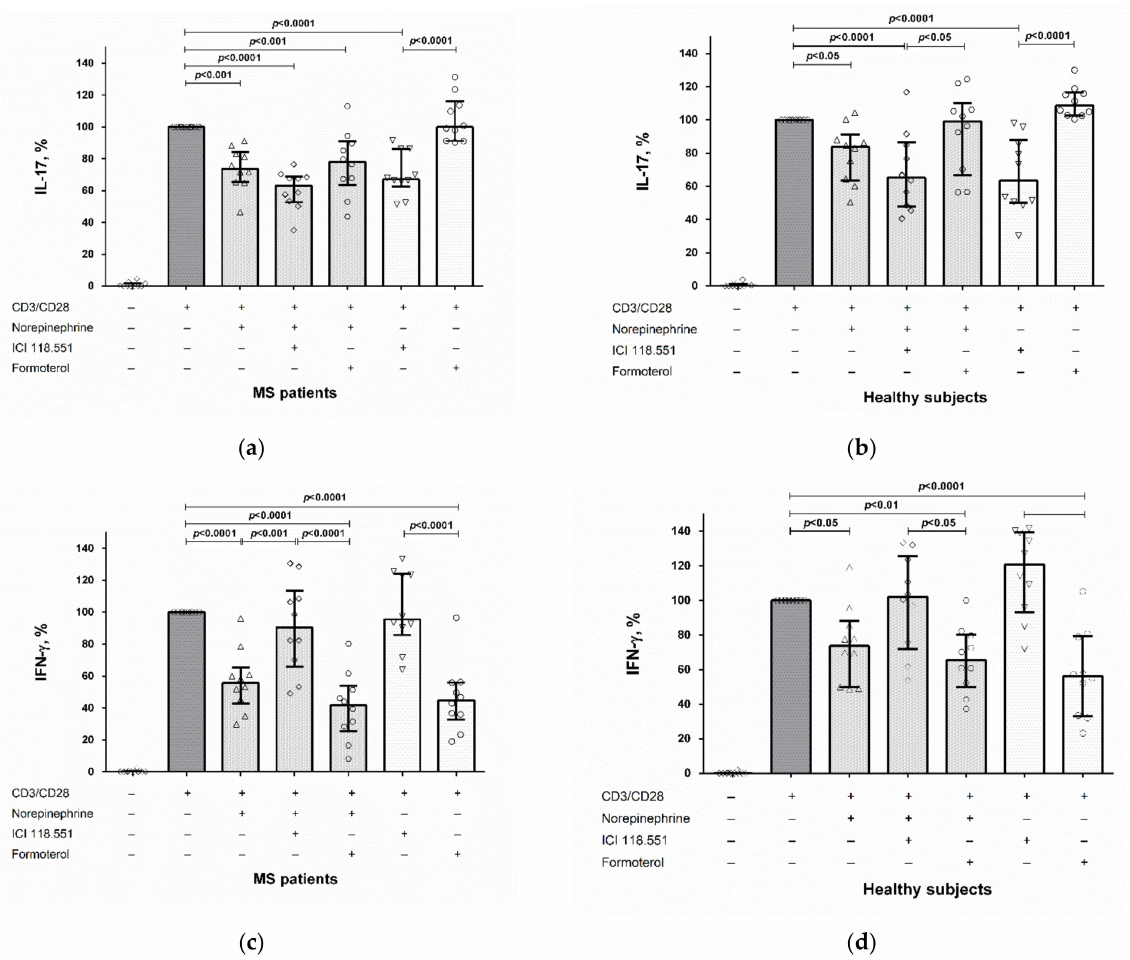
Figure 3. The role of the β 2 -adrenergic receptor in the norepinephrine-mediated suppression of IL-17 ( a , b ) and IFN- γ ( c , d ) production by stimulated PBMCs in MS patients and healthy subjects. CD4 + T cells (8 × 10 4 per 200 µ L per well), obtained from MS patients or from healthy subjects, were pre-incubated with an antagonist or an agonist of the β 2 -adrenergic receptor (ICI 118.551 and formoterol, respectively) (at 10 − 6 M), whereafter norepinephrine (at 10 − 5 M) and anti-CD3/anti- CD28 microbeads or anti-CD3/anti-CD28 microbeads (without norepinephrine) were added to the cultures. After 72 h, the supernatants were collected and submitted to cytokine quantification by ELISA. Data are expressed as the percentage of cytokine production by stimulated cells in the absence of norepinephrine and β 2 -adrenergic receptor antagonist or agonist. The boxes in the graphs correspond to the medians and the whiskers indicate to 25th and 75th percentiles. The symbols in the graphs correspond to the data from each separately MS patient or healthy subject. The median values of the MS and control groups were compared, and the p values are indicated in the